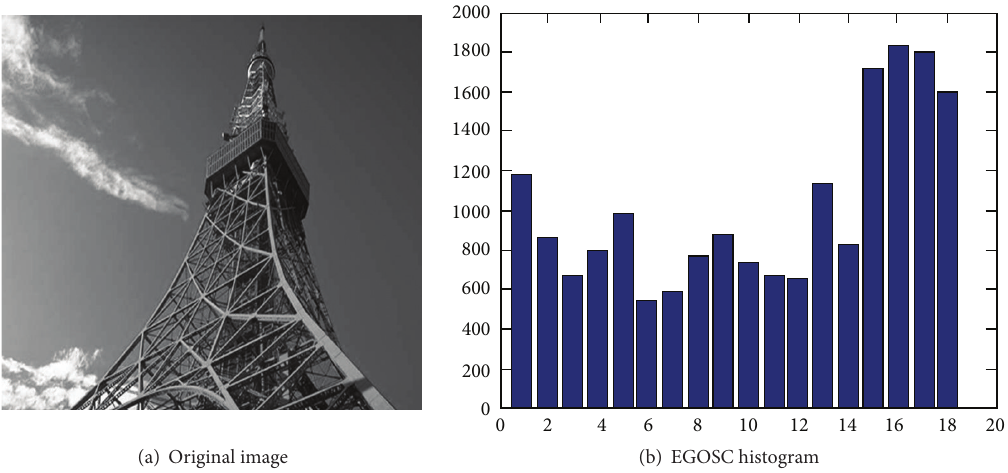
Figure 3: Image of an iron pagoda and its EGOSC